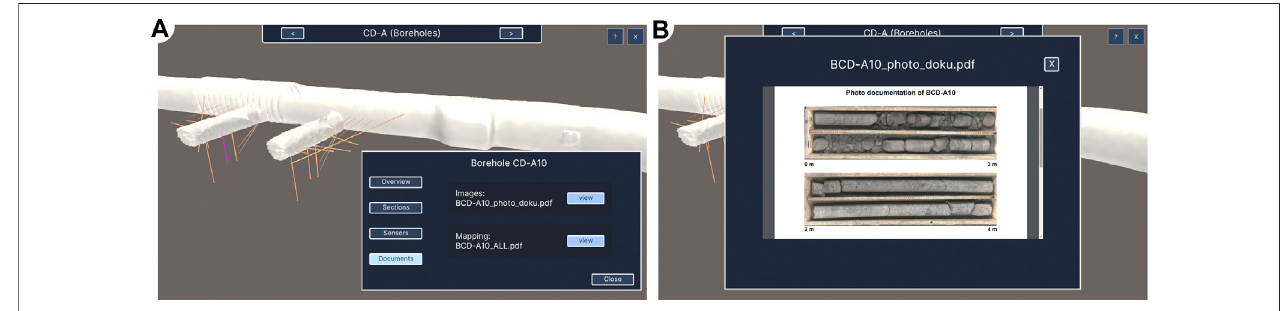
rotation and translation of the current point of view. The key bindings and interaction instructions are displayed in Figure 12 .